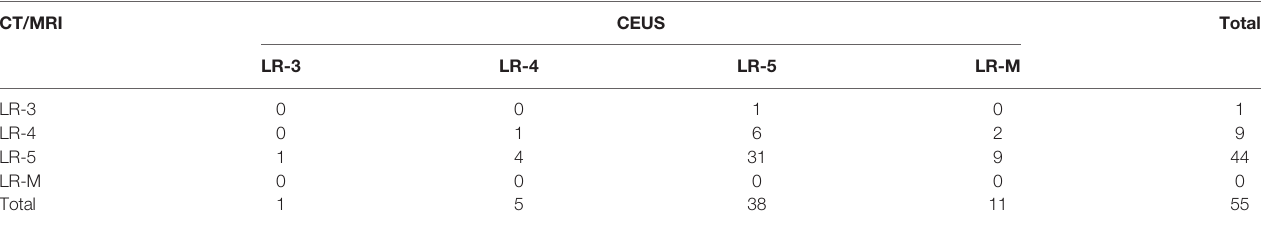
TABLE 5 | LI-RADS categorizations of HCCs by CEUS and CT/MRI. CT/MRI